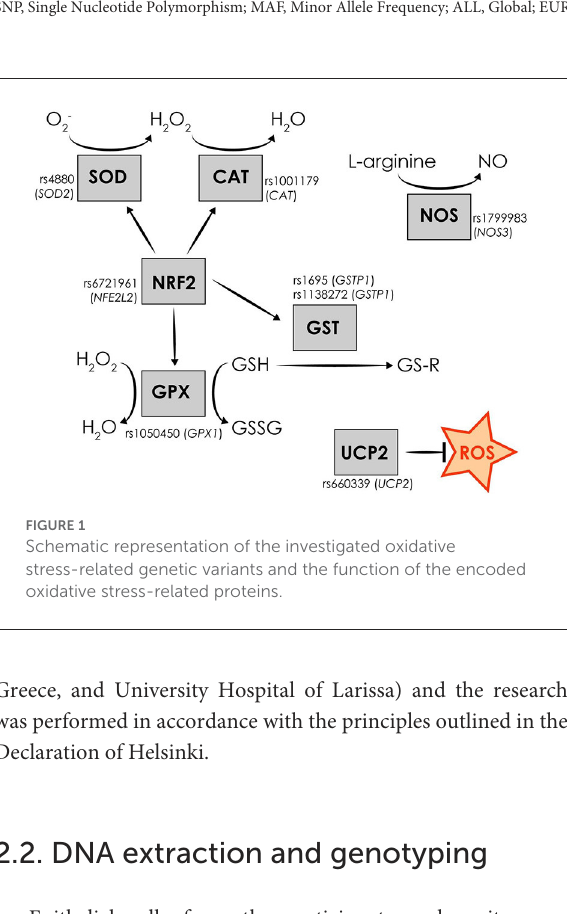
Greece, and University Hospital of Larissa) and the